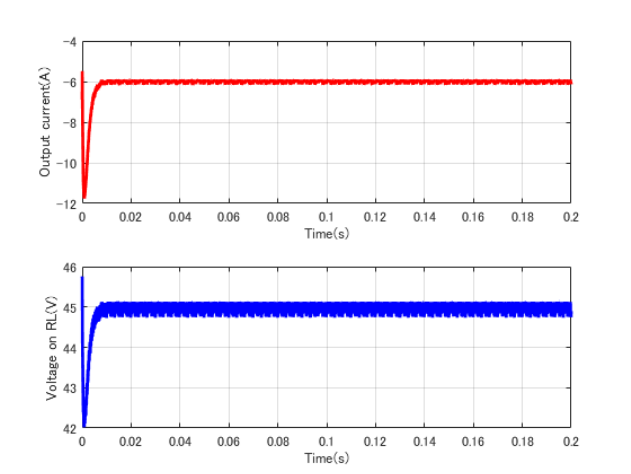
Figure 18. Output waveform of voltage on R L .